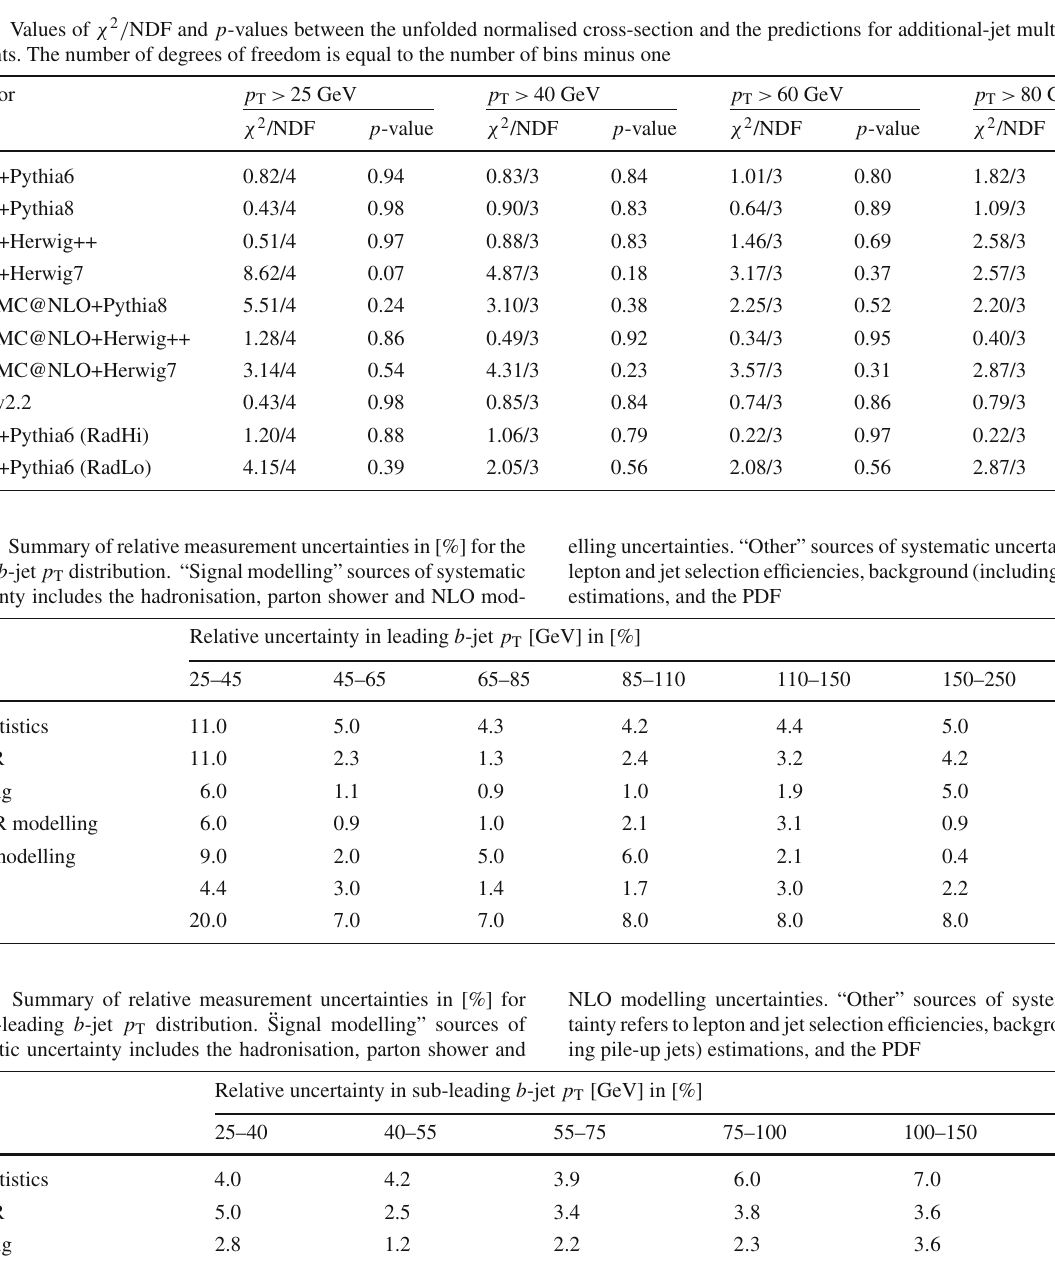
Table 6 Values of χ 2 / NDF and p -values between the unfolded normalised cross-section and the predictions for additional-jet multiplicity mea- surements. The number of degrees of freedom is equal to the number of bins minus one